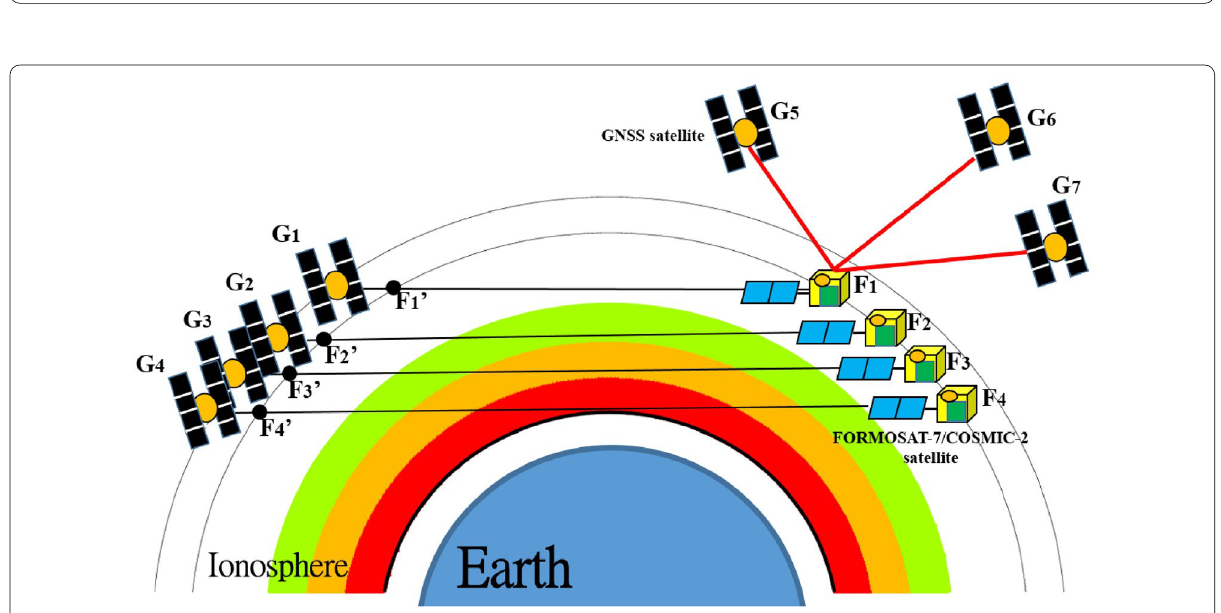
Fig. 2 Illustration of RO ionospheric